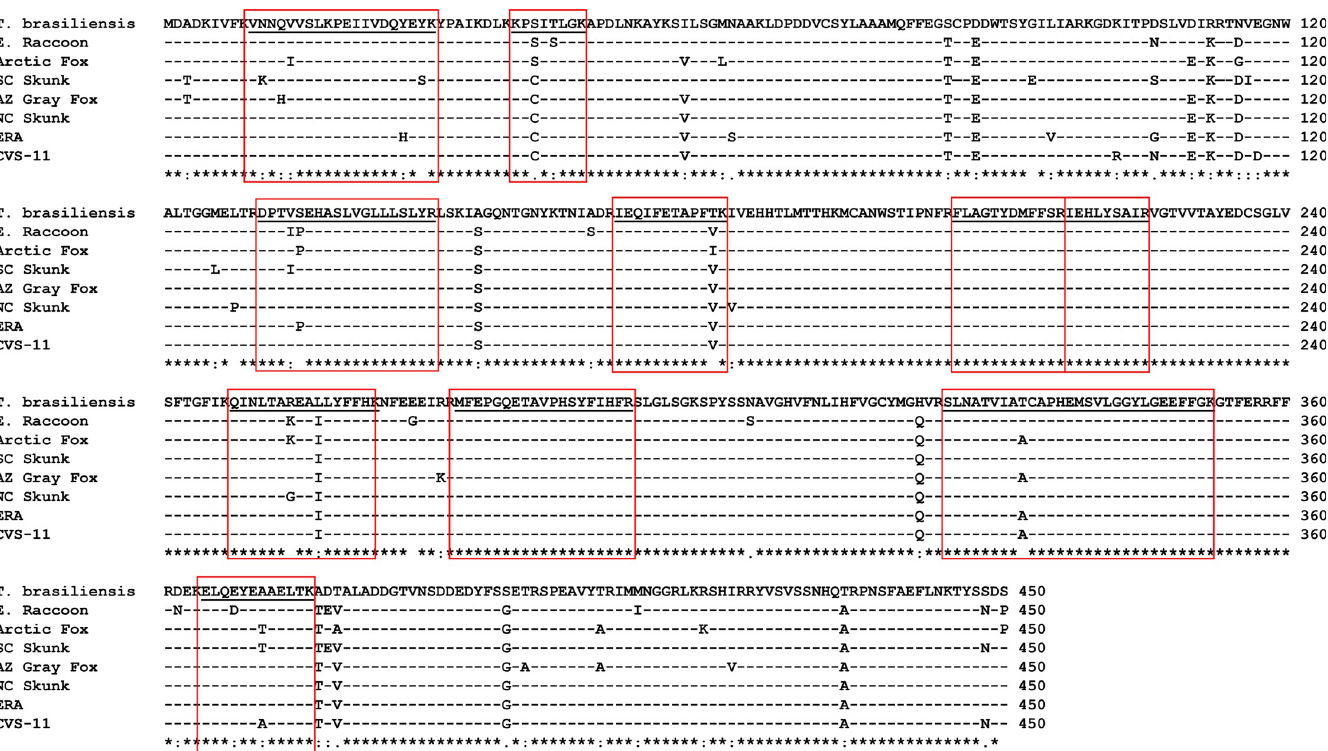
Fig 5. Clustal alignment of N protein amino acid sequences from different RABV variants used in this study. N protein amino acid sequence from representative RABV variants circulating in different hosts are compared using Clustal Omega program. N protein from E Raccoon (GenBank U27221.1), NC Skunk (AF461045.1), SC skunk (ADF80603.1), AZ gray fox (JQ685899.1), Arctic fox (AEV22313.1), T . brasiliensis (bat, ACN51665.1), CVS-11 (Q8JXF6.1) and ERA (P0DOF3.1) are aligned by Clustal analysis. The most frequently observed peptide fragments in MS are underlined and boxed to demonstrate the conservation or differences in RABV